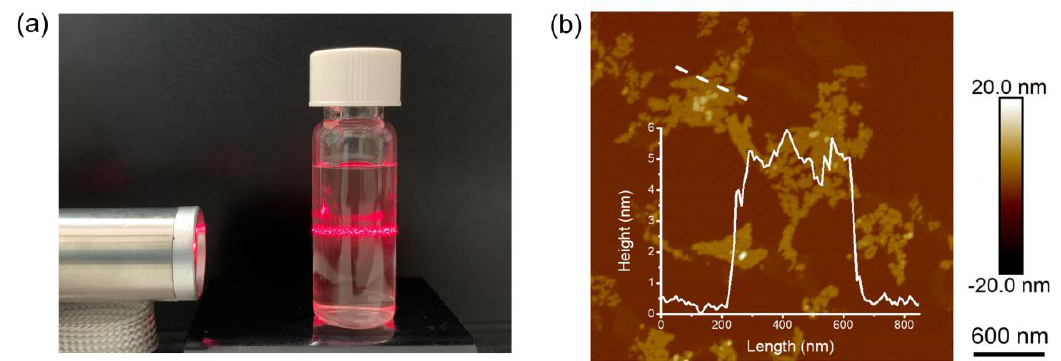
Figure 2. ( a ) Tyndall effect, ( b ) AFM image of EB − TAPB − TFP NSs. Inset indicates the corresponding height profile.